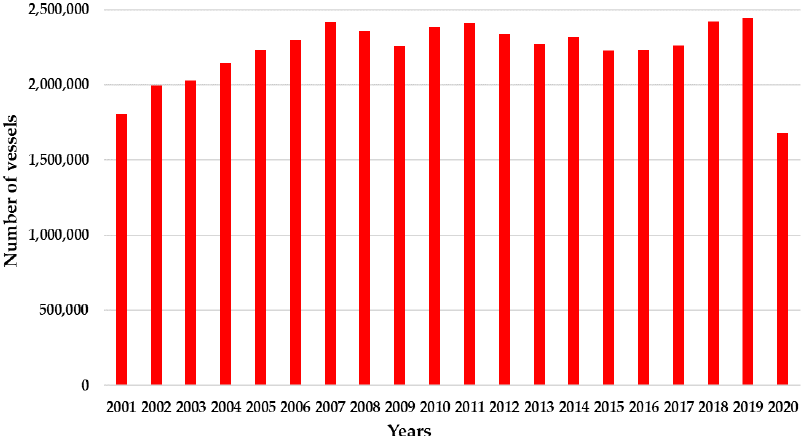
Figure 3. Total number of vessels in the main ports of European countries for the period 2001 – 2020.